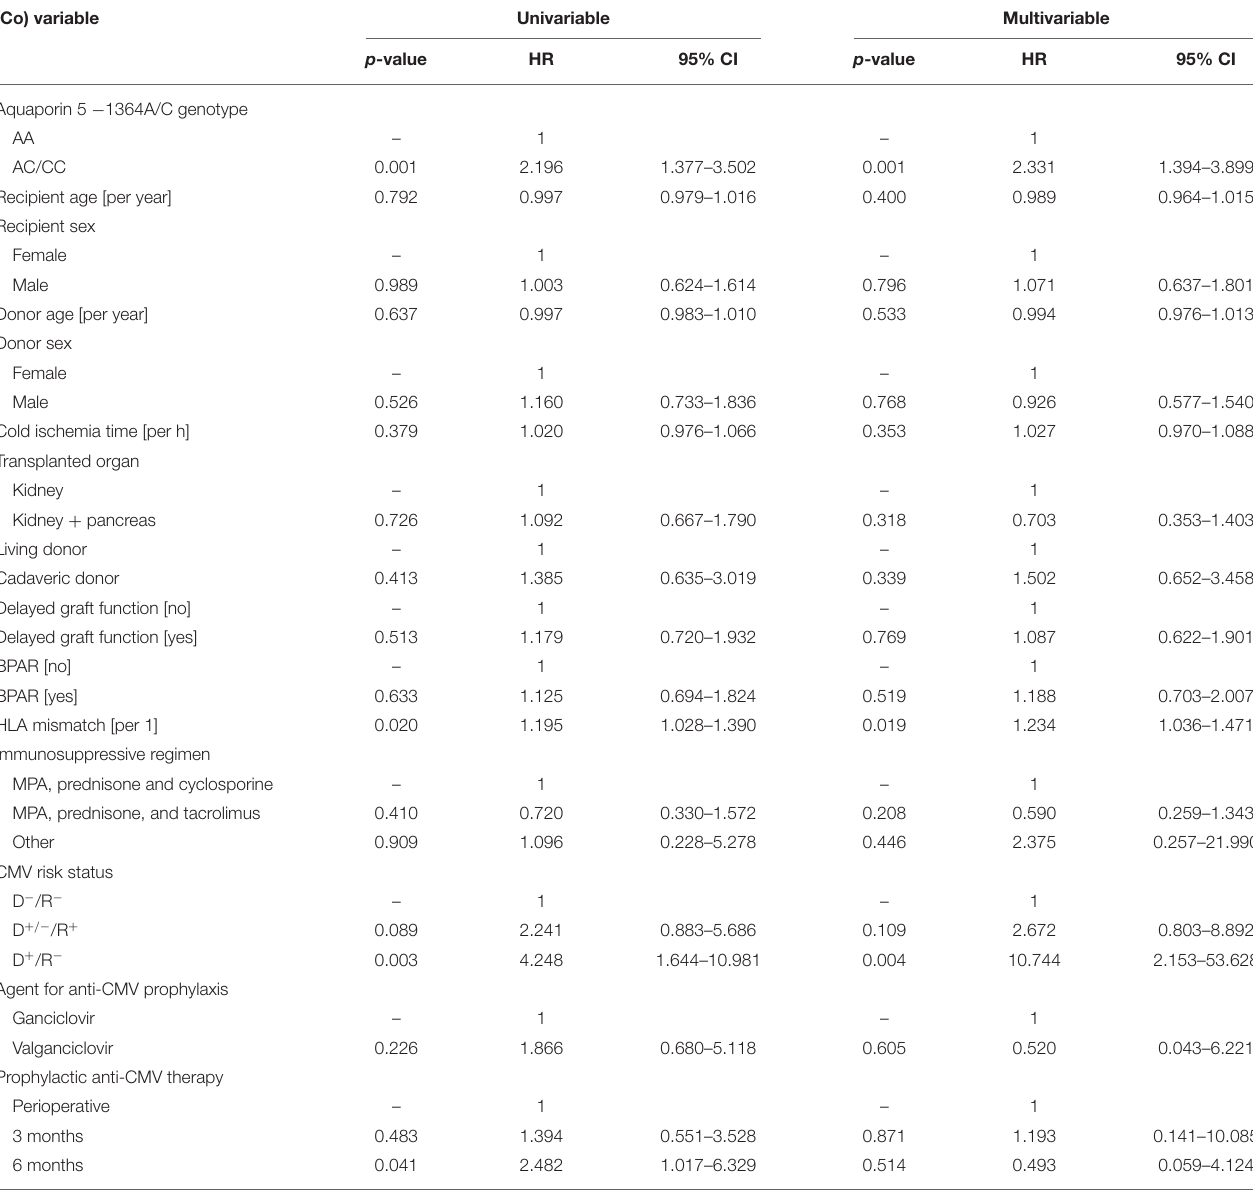
TABLE 3 | Univariable and multivariable Cox regression analysis of kidney transplantation recipients regarding the effect on cytomegalovirus infection risk. (Co)